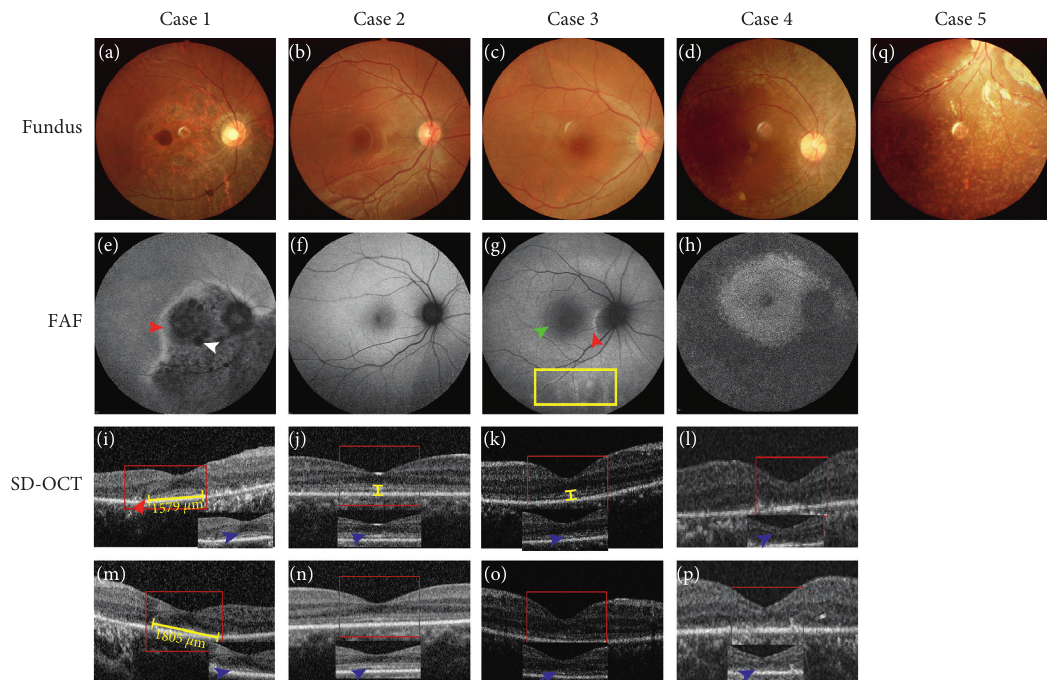
Figure 2: Fundus photography, fundus autofluorescence imaging, and foveal optical coherence tomography scans of probands from the LCA6 families. The fundus image of both eyes in case 1 (a: right eye), the pigment mottling pattern, symmetry atrophy of the retina at the inferior-nasal area, and AF of the right eye (e: right eye). Hypofluorescence is coincident with an area of the retina atrophy, mottled pigmentary (white narrow), and hyperfluorescent boundary (red narrow). The SD-OCTscan showed that the ellipsoid zone is preserved in the central macular that marks the horizontal length with a yellow line, 1579 μ m and 1805 μ m, respectively (blue arrows; i: right eye, m: left eye). The boundary line of the ellipsoid zone (red arrow) between the reserved and atrophy areas (i: right eye, m: left eye). Fundus photographs (b right eye) and autofluorescence (f: right eye) of case 2 indicate both eyes are close to normal, while the SD-OCTof both eyes (j: right eye, n: left eye) shows that the adjacent lamellar structure is thinner and that there is a preserved ellipsoid zone within a 6mm horizontal length (blue narrows, yellow line). The case 3 fundus (c: right eye) does not show an abnormality, but the enlarged hypo- fluorescence area of the macula (green arrow), hyperfluorescent ring (red arrow) around the optic disc, and the subtemporal mottled hyperfluorescence (yellow box) (g: right eye). The OCTshows the thinning of all retinal layers and blurred ellipsoid areas (blue arrows and yellow line; k: right eye, o: left eye). The fundus image of case 4, peripheral pigmentation, and the pigment change (d: right eye). The AF of the right eye shows that except for a concentric hyperfluorescent area (hyperfluorescent ring), it is coincident with an area of no retinal pigmentation and pigmentary deposits in the remaining area of the retina (h: right eye). The OCT shows that both eyes of all layers are unrecordable, including the disappearing ellipsoid zone in the foveal area (blue arrows; l: right eye, p: left eye). The fundus photographs in case 5 show attenuated retinal vessels and a mottled pigmentary change (q: right